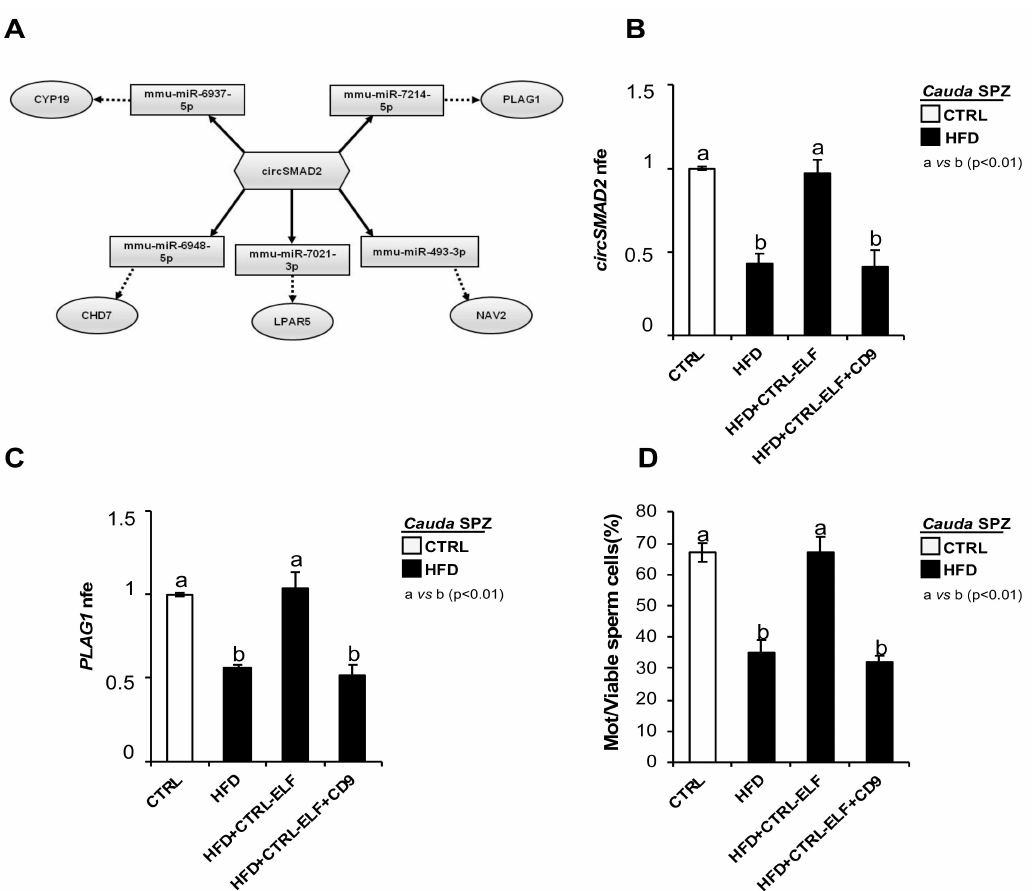
Figure 6. In vitro experiment of vesicle shuttle: from CTRL epididymis to HFD SPZ. ( A ) CeRNET of one circRNA downregulated in HFD SPZ. CircSMAD2 tethers a group of miRNAs as targets, all involved in sperm motility pathways. Networks were built using Cytoscape. Hexagonal and rectangular symbols represent circRNAs and miRNAs, respectively. The arrow indicates the tethering activity of circRNAs toward miRNAs, while the dotted arrow indicates the pathways upstream of the miRNAs. ( B , C ) qRT-PCR analysis of circSMAD2 ( B ) and PLAG1 -mRNA ( C ) in CTRL cauda SPZ and HFD cauda SPZ in vitro coincubated with: PBS, CTRL-ELF, and CTRL-ELF pretreated with anti-CD9 antibody (n = 6 for each experimental group). qRT-PCR data were normalized using cyclophilin , expressed as fold expression (nfe) relative to CTRL SPZ and reported as mean value ± S.E.M. Experimental groups with statistically significant differences ( p < 0.01) were indicated with different letters. ( D ) Sperm motility assay in CTRL cauda SPZ and HFD cauda SPZ in vitro coincubated with: PBS, CTRL-ELF, and CTRL-ELF pretreated with anti-CD9 antibody (n = 6 for each experimental group); data were expressed as the percentage of motile/live SPZ and reported as mean ± SEM. Experimental groups with statistically significant differences ( p < 0.01) were indicated with different